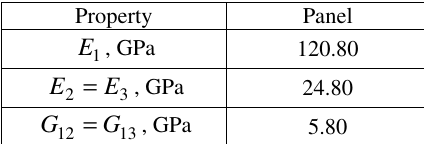
Table 1. Elastic constant obtained by identification Property